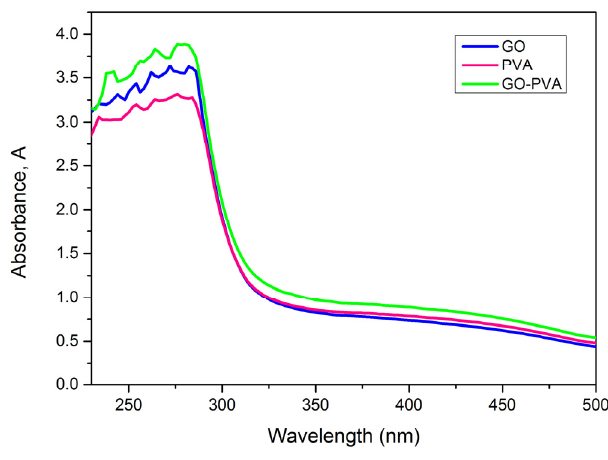
Figure 4. UV-Vis absorbance spectrum of GO, PVA, and GO–PVA thin film.